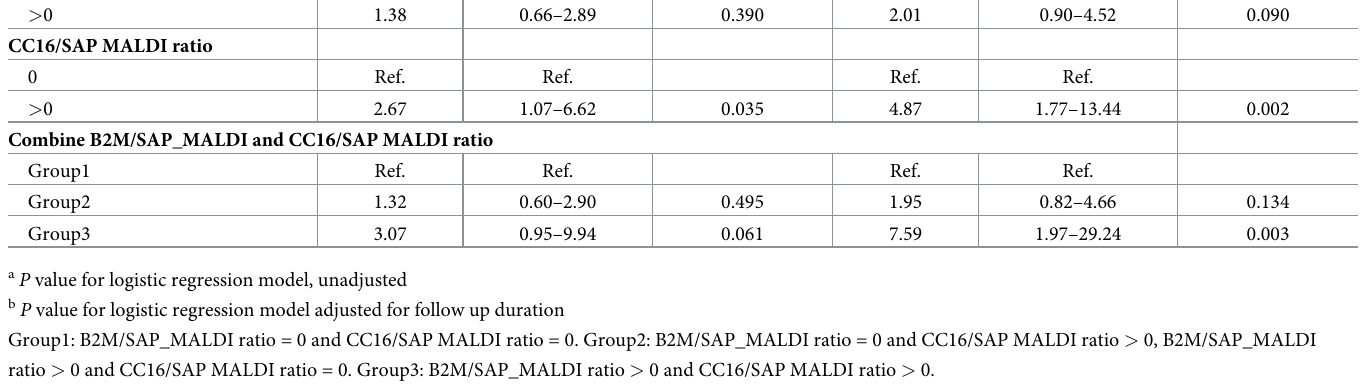
Logistic regression was used to further examine the effect of potential biomarkers, B2M and CC16, independently or combined on ERFD (Table 3). When comparing individuals having marker with those without marker, the OR for ERFD was 2.01 (95% CI: 0.90–4.52) for B2M